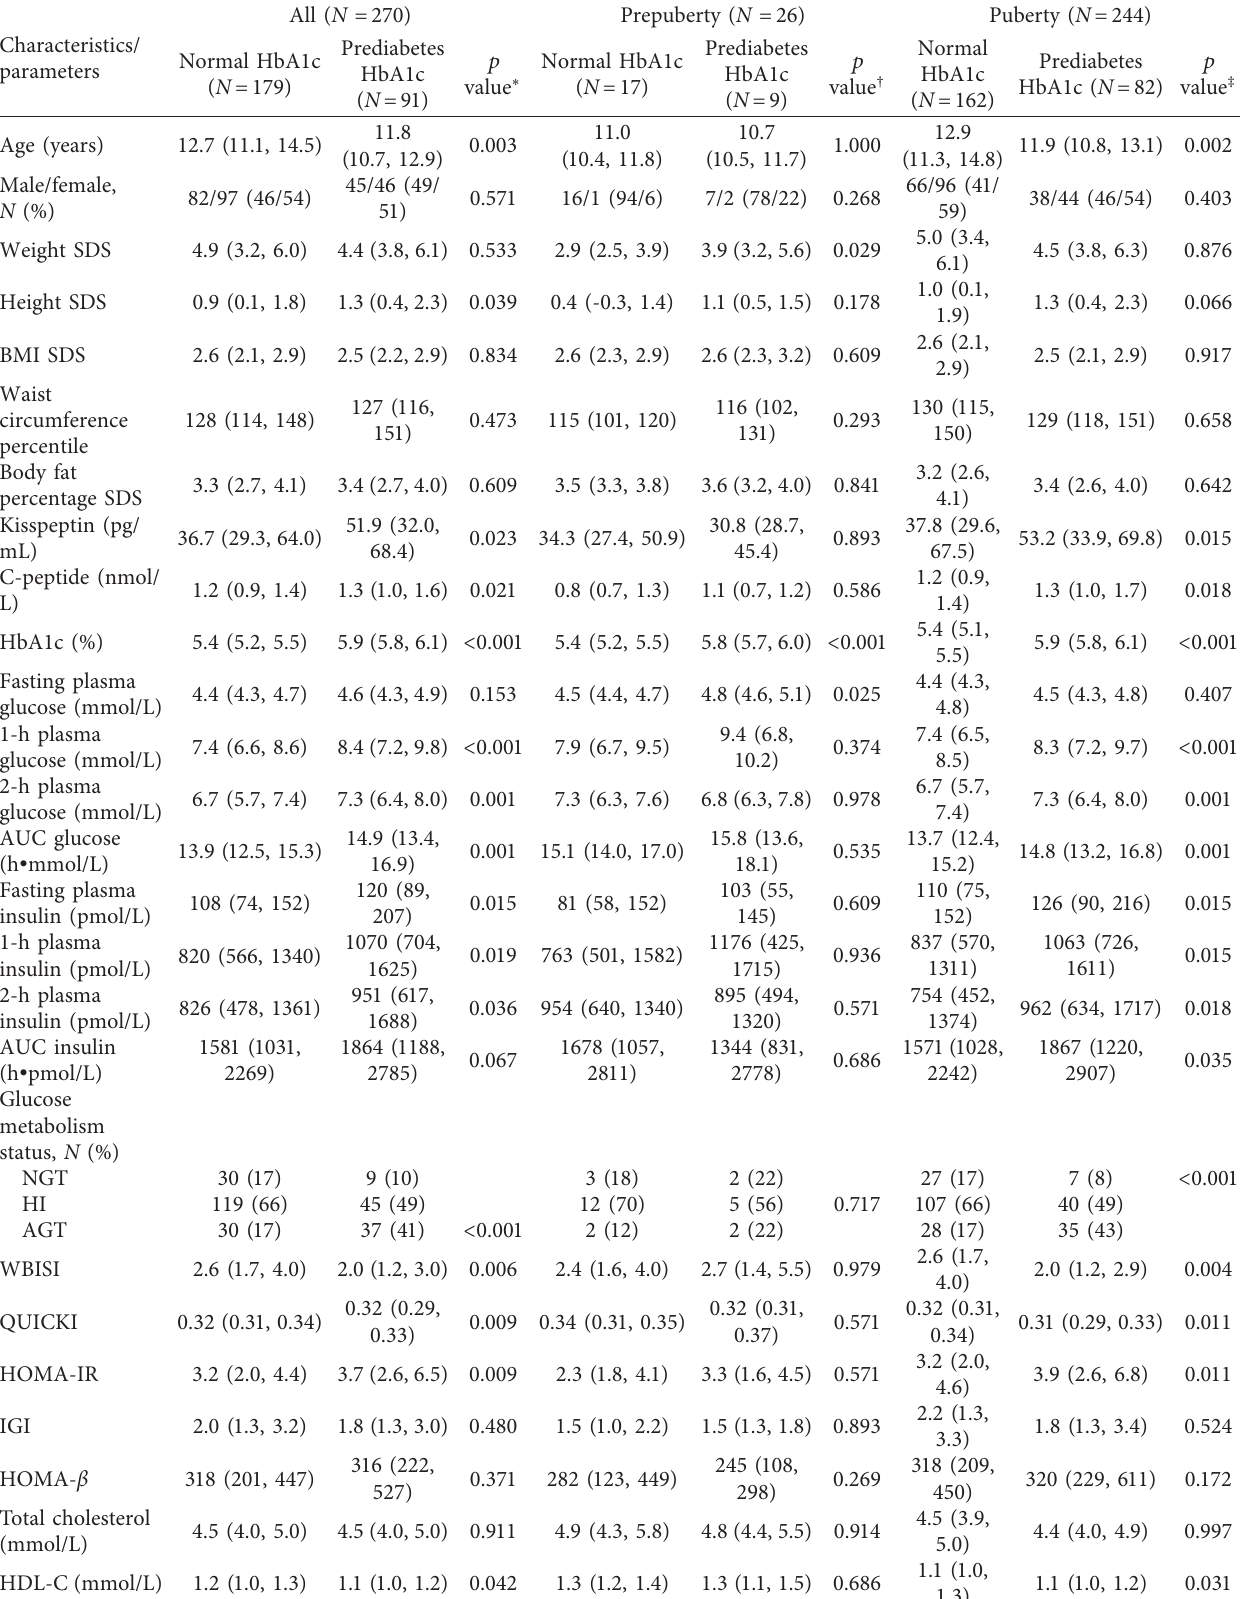
Table 1: Clinical characteristics and related parameters of all patients and each subgroup of pubertal status according to HbA1c.